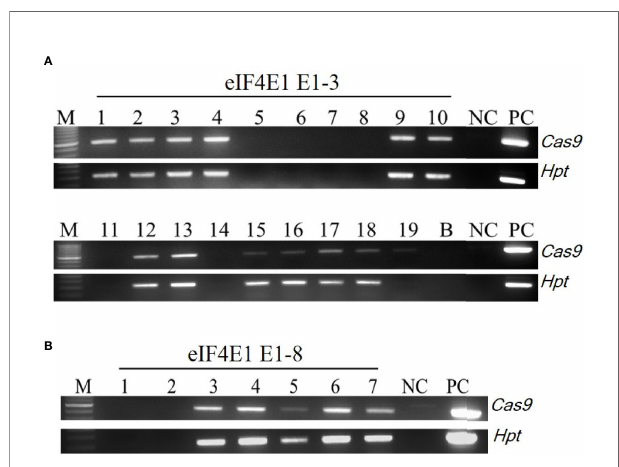
FIGURE 3 | Transgene screening of eIF4E1 -edited E 1 progeny. (A, B) Transgene screening of eIF4E1 -targeted E 1 progeny of E0-3 ( A ; 19 progeny) and E0-8 ( B ; 7 progeny) by genomic DNA PCR. NC, wild type (negative control); PC, Cas9 plasmid (positive control), Hpt , Hygromycin phosphotransferase marker